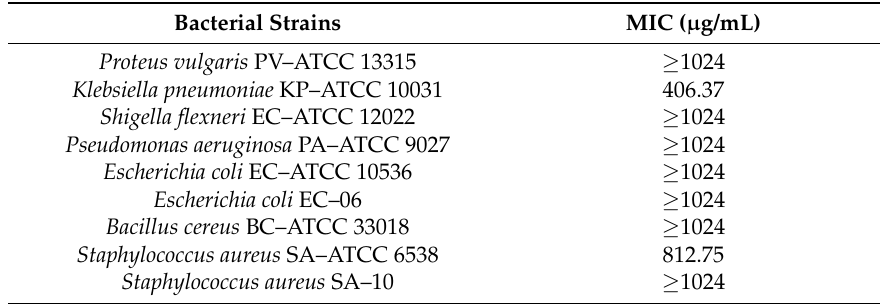
Table 4. Minimum inhibitory concentration values ( µ g/mL) of the fixed oil of the almond of O. speciosa . Bacterial Strains MIC ( µ g/mL) Proteus vulgaris PV–ATCC 13315